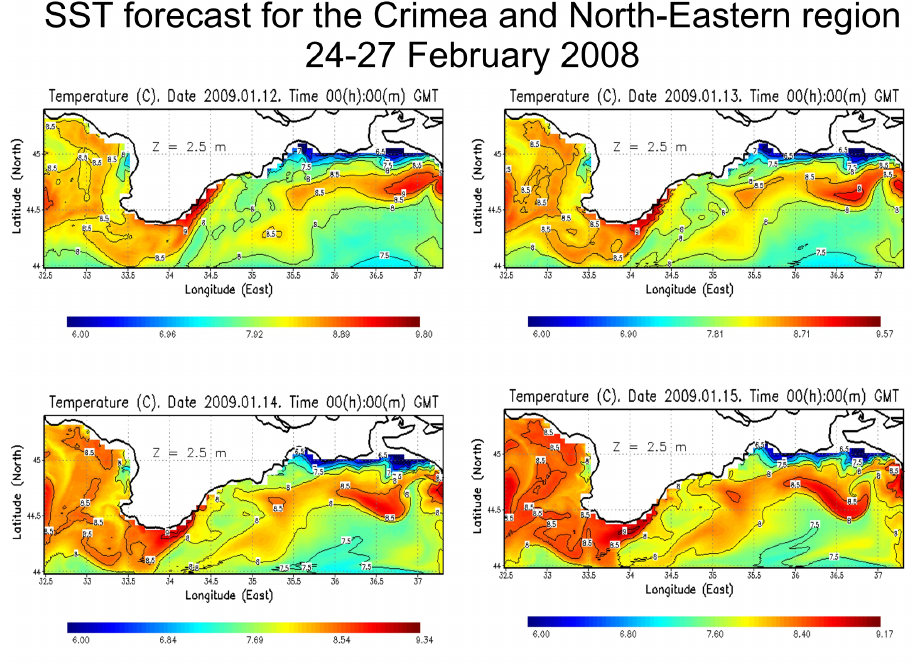
Fig. 6. Examples of analysis and forecast of SST: (a) on the north-western shelf region (area NWS) and (b) near the Crimea cost (area C). Upper left is the analysis, upper right – one day forecast, bottom left – two days forecast and bottom right – three days